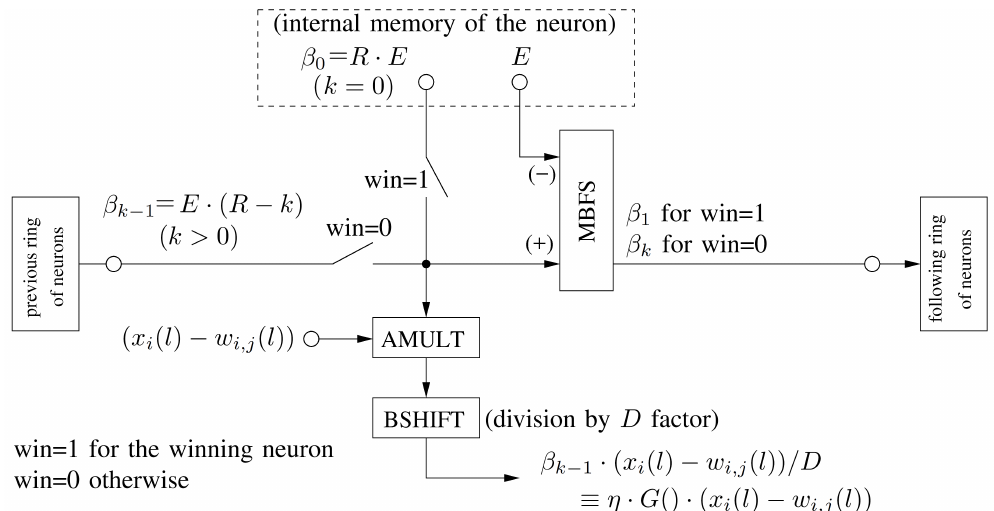
Figure 7. The proposed solution of the neighborhood and the adaptation mechanism with only one multiplication operation. The SUB block is the multi-bit full subtractor. AMULT is asynchronous multiplier, BSHIFT is division circuit (shifting bits to the right), MBFS is multi-bit full subtractor.